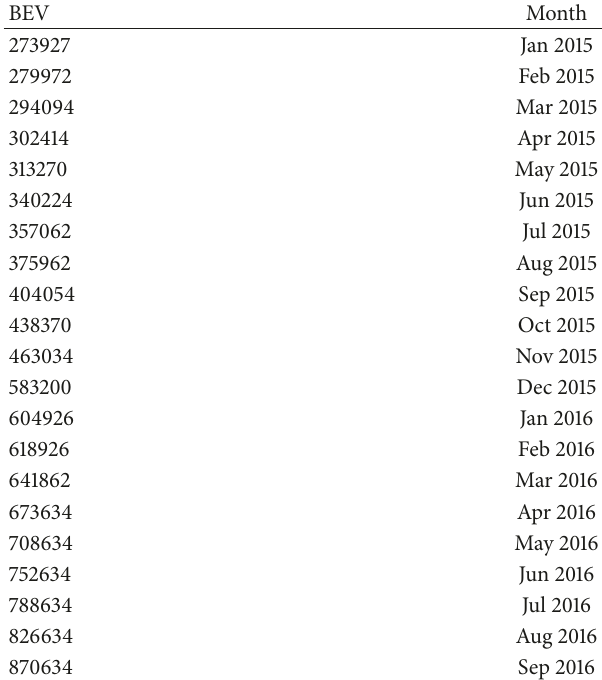
Table 1: The amount of BEV ownership from Jan 2015 to Sep 2016 in